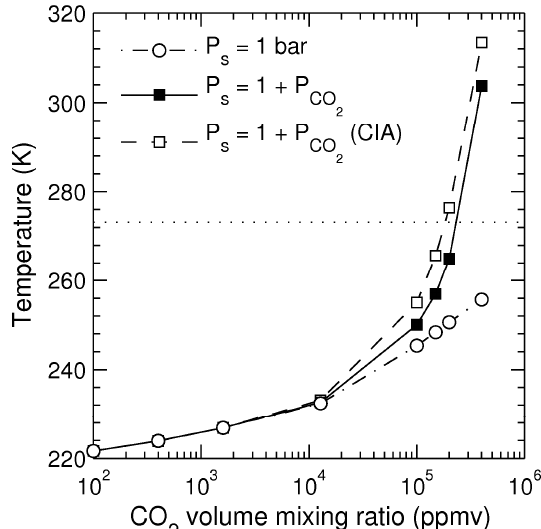
Figure 5. Total surface pressure as a function of CO 2 volume mixing ratio. Figure 6. Surface temperature as a function of CO 2 volume mixing ratio as the contribution of CO 2 partial pressure to total pressure is considered. Circle-dashed-dotted line: surface pressure is held constant, i.e., P s = 1.0 bar, black-square-solid line: P s = 1.0 + CO 2 partial pressure (P co2 ), with only pressure broadening of absorption considered, and square-dashed line: P s = 1.0 + P co2 , with both pressure broadening and collision-induced absorption (CIA) of CO 2 are considered. Here, the zenith angle is 60º.